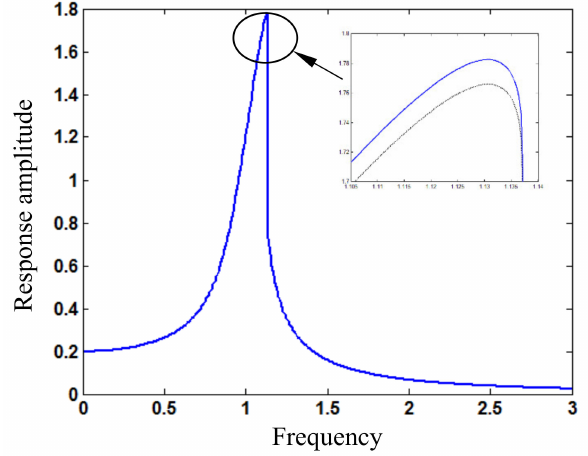
Figure 2. Amplitude ( w Am ) frequency ( ω ) relation around principal resonance for loading amplitude F s 1 = 0.2 (blue solid line: response based on periodic solution; black dotted line: response based on first harmonic term).